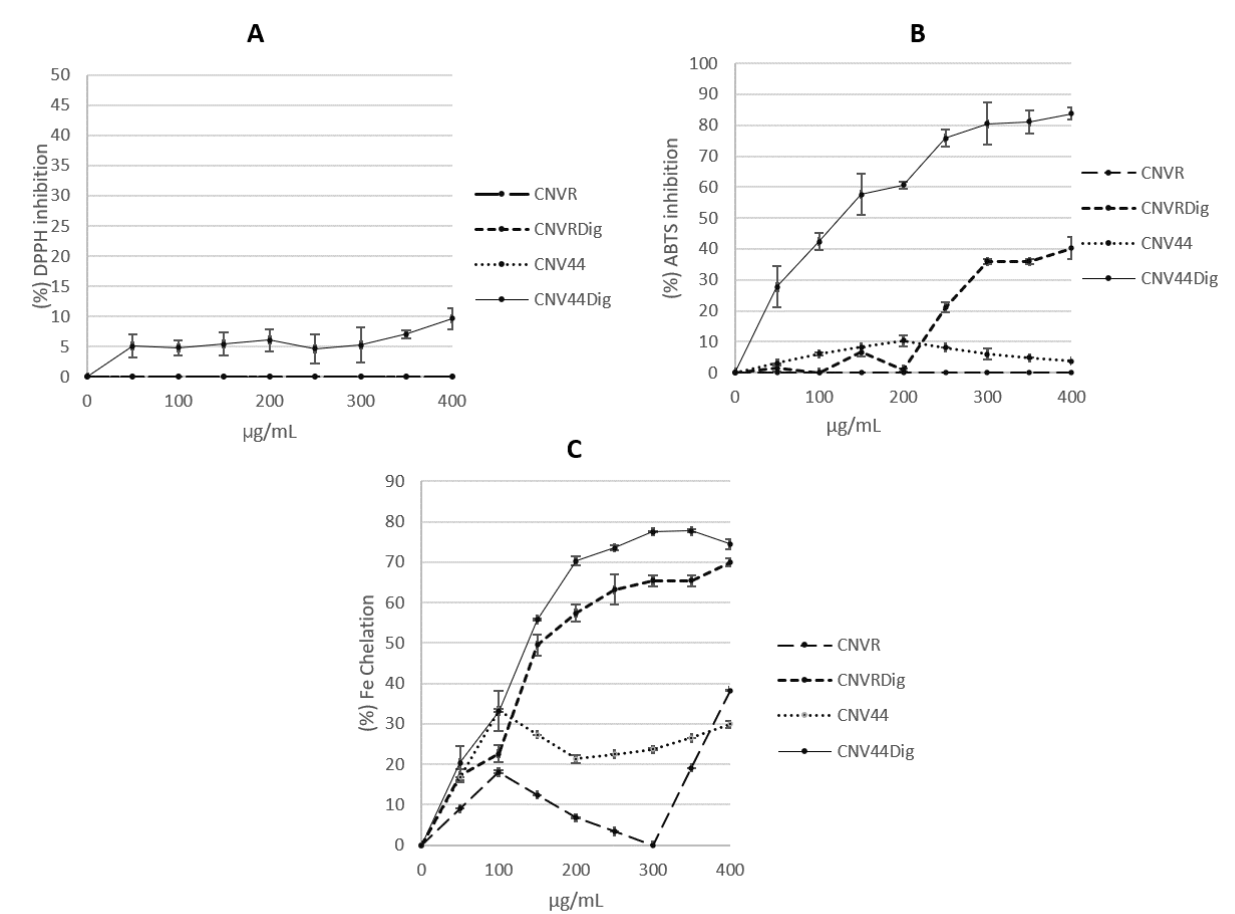
Figure 6. Antioxidant activity of CNVR and CNV44 and their hydrolysates by different techniques, DPPH, ABTS and Iron chelation. ( A ): DPPH radical scavenging, ( B ): ABTS inhibition, ( C ): Iron quelation.